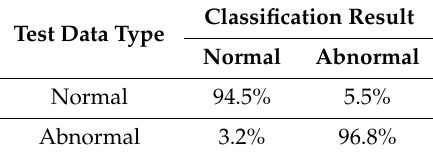
Table 6. Accuracy of anomaly